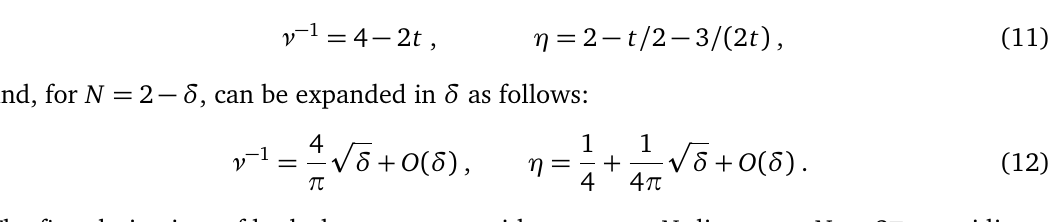
Figure 3: (Color online) Comparison of the exponent η calculated for α depending on dimensionality d for N =